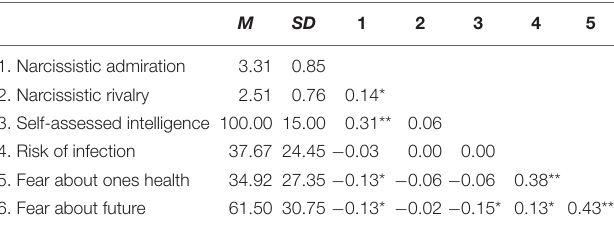
TABLE 2 | Correlations between narcissism, self-assessed intelligence, perception of COVID-19 situation and descriptive